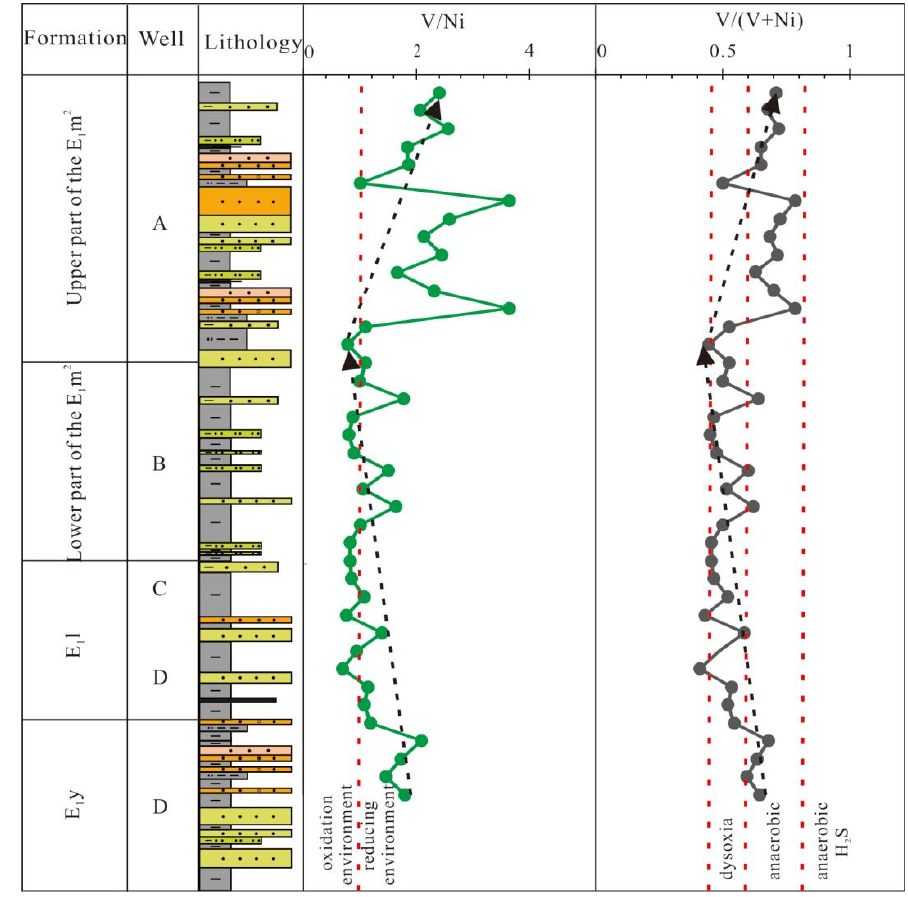
Figure 15. The variation trend of V/Ni and V/(V + Ni) in the West Lishui Sag. Compared with the V/Ni and V/(V + Ni) ratios of the E 1 m 2 , the V/Ni ratios of the E 1 l 1 and the E 1 l 2 were small, indicating that their reducibility was weaker than that of the E 1 m 2 , which is consistent with the conclusion of Cu/Zn. The fluctuation of V/Ni ratios in the E 1 m 2 is speculated to be related to the frequent transgression and regression during this period (Figure 5). On the whole, the V/Ni and V/(V + Ni) ratios indicate that the Paleocene in the West Lishui Sag was in a relatively strong reducing environment. Based on the analysis results of Cu/Zn, V/Ni, V/(V + Ni), and the paleobathymetry, it is considered that the West Depression of Lishui Sag was in a reducing environment during the Paleocene as a whole. The E 1 y was the most reductive, with deep paleobathymetry and anoxic at the lake bottom, which was conducive to the accumulation and preservation of the hydrogen-rich organic matter caused by phytoplankton. The water body of the E 1 l in the sampling section was relatively shallow and mainly formed in an